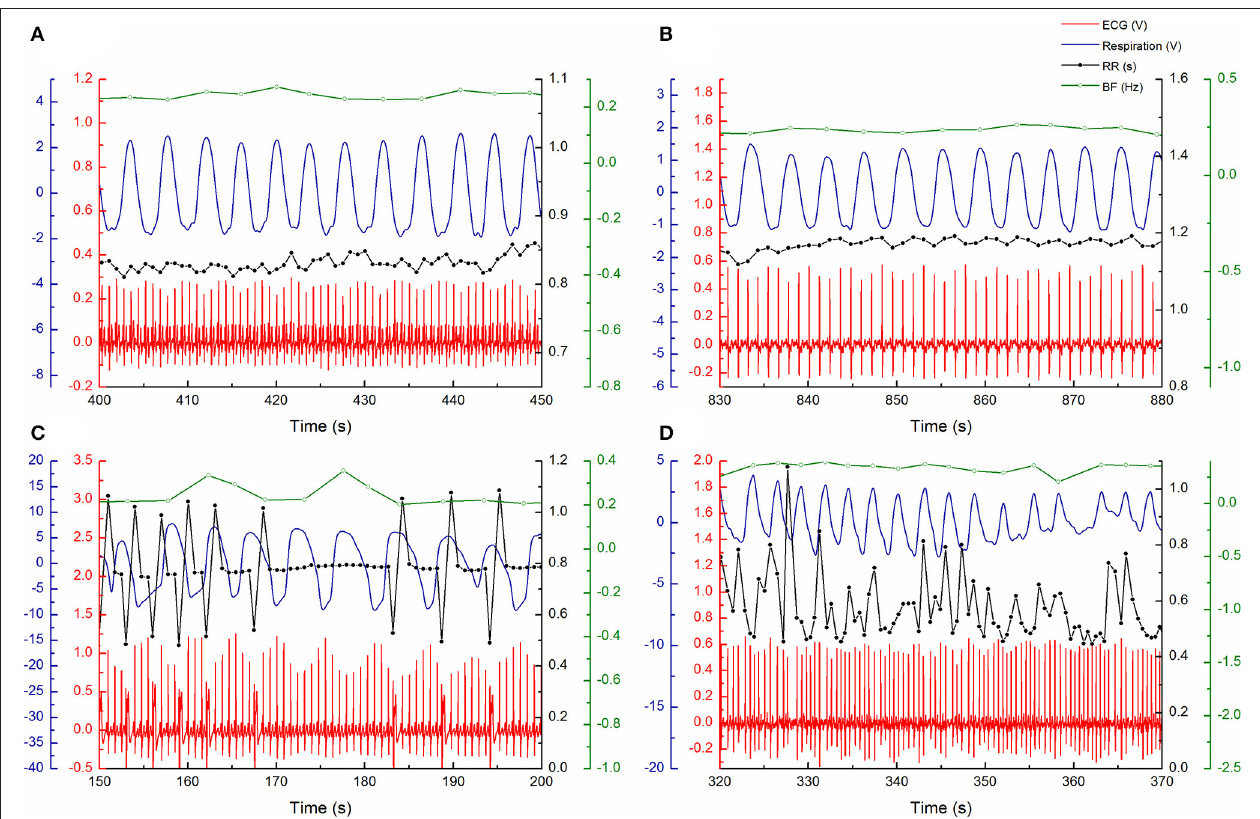
FIGURE 1 | Examples of measured ECG (red) and respiratory (blue) signals and RR intervals (black) and respiratory rate (green) signals during arbitrary period of 50 s: (A) in 51 year old control subject, (B) 59 year old heart failure patient with sinus rhythm, (C) 62 year old heart failure patient with ventricular extrasystoles, and (D) 65 year old heart failure patient with atrial